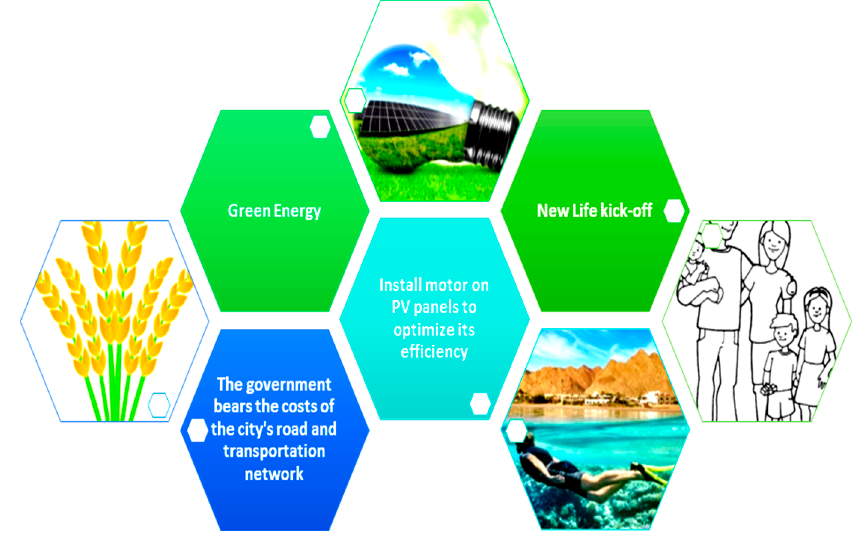
Figure 13. Key success indicators in Wadi-Dara on the Red Sea coast, Egypt .